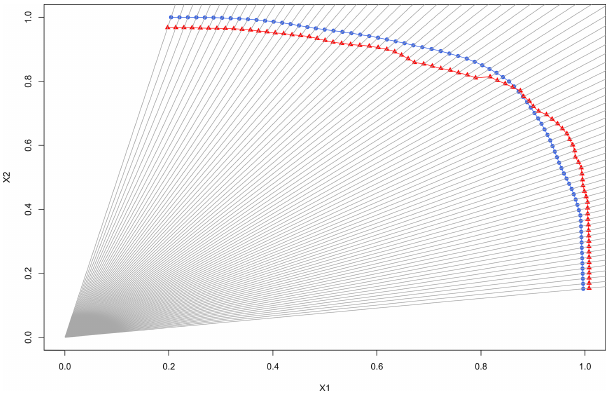
Figure 6. Procedure for computation of the goodness-of-fit indi- cators. Two variables are given, X 2 as a function of X 1 . The red triangles and red curve represent the modelled level curve from a given model. The blue circles and blue curve are the reference level curve from the underlying bivariate ( X 1 , X 2 ) distribution of the data. Distance between the curves is calculated along the radius at 80 ( X 1 , X 2 ) coordinates (e.g. between the blue circles and the red